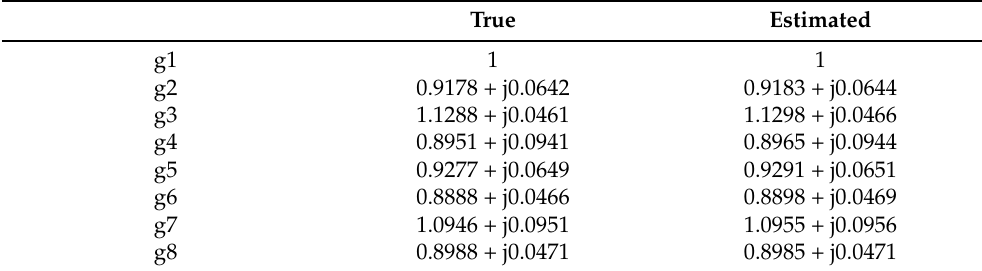
Table 2. Gain and phase errors